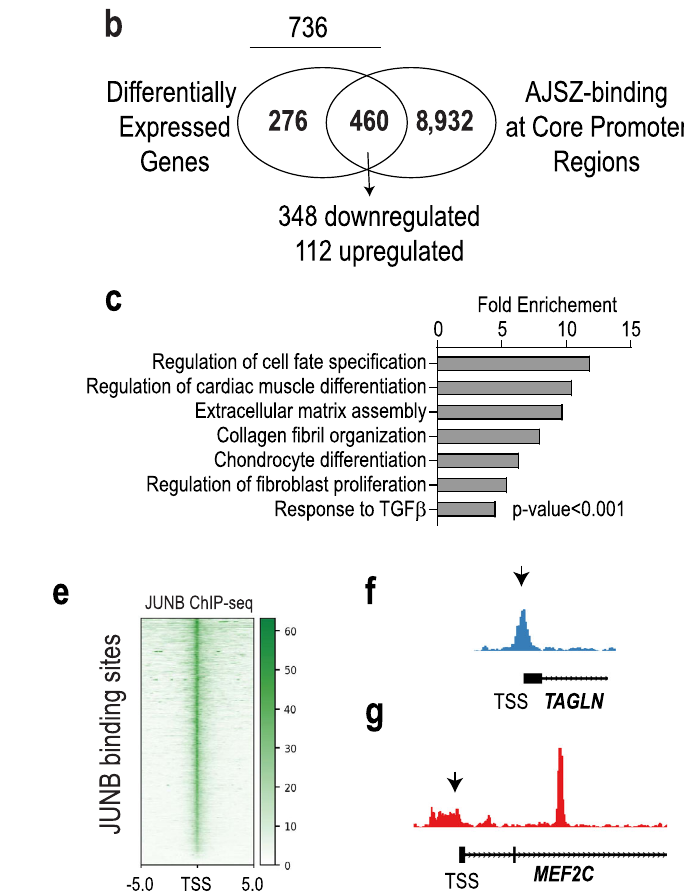
Fig. 5 | AJSZ proximally regulates gene expression during cell fate repro- gramming. a Heatmap of differentially expressed (DE) genes in siControl- and siAJSZ-transfectedHDFs2daysafterMGToverexpression b Venndiagramshowing the overlap betweenDE and corepromoter-bound ( − 1kb-TSS- +0.1kb) genes. 460 genes were both DE and bound by AJSZ at core promoter regions, including 348 downregulated and 112 upregulated genes. c Bar charts showing top-ranked